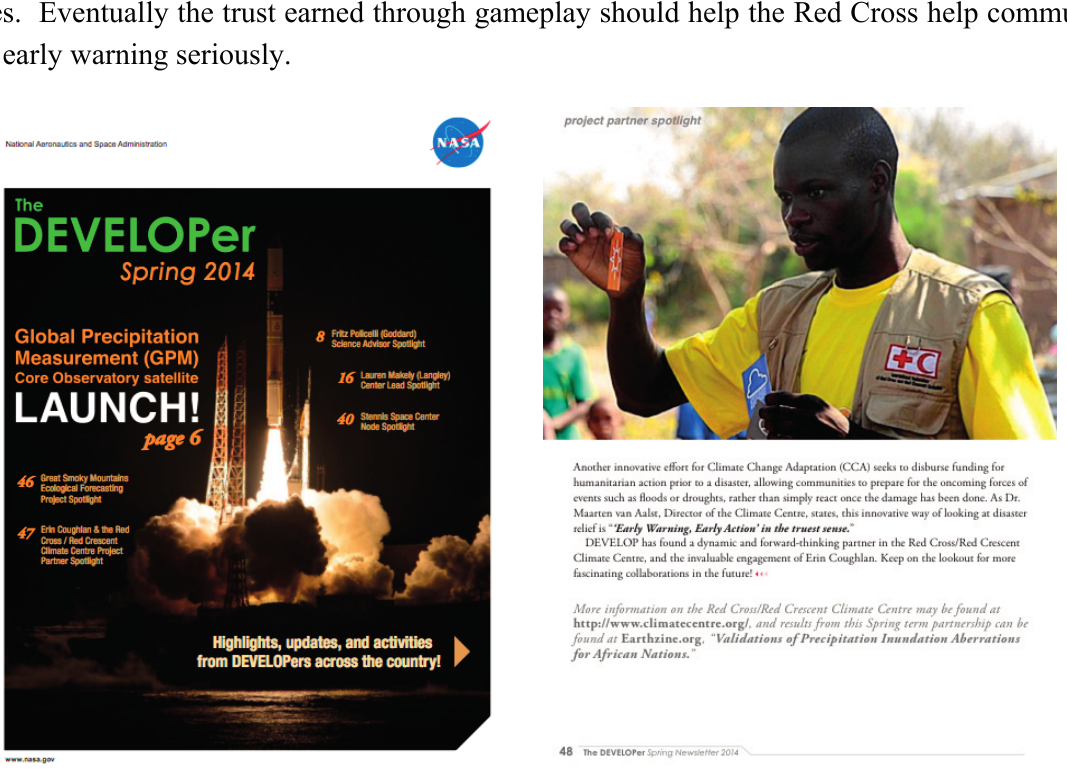
Figure 5. The game UpRiver, facilitated by a Red Cross volunteer from the village of Kazungula in western Zambia, was featured in a NASA publication to highlight the value of flood prediction. Engagement games can help raise awareness and visibility of initiatives involving